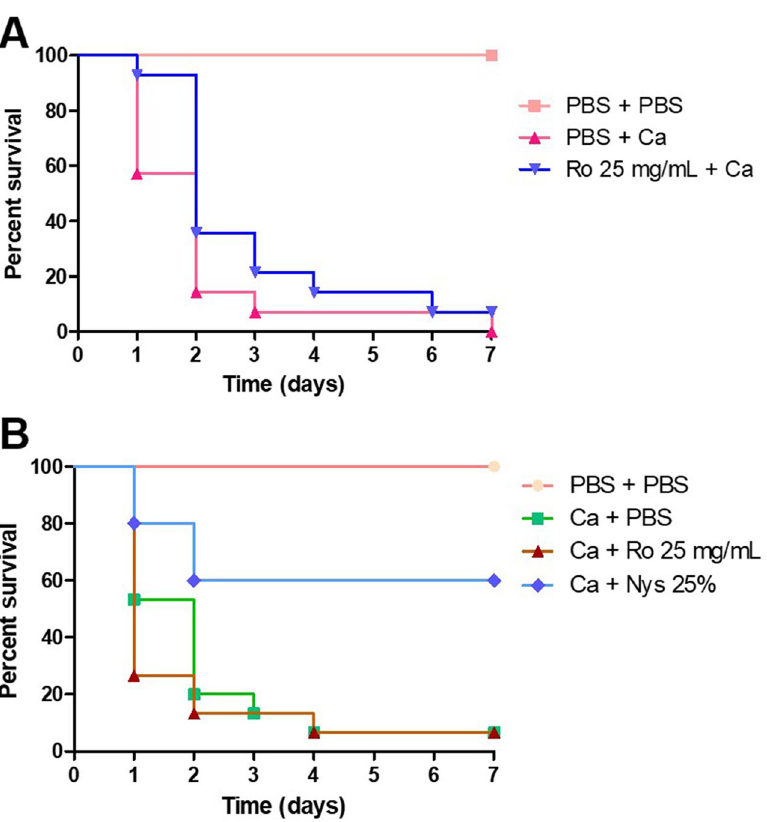
Figure 2. Galleria mellonella survival curve after treatment with different groups. ( A ) To compare the antifungal action of the prophylactic groups with the control group (PBS + PBS). ( B ) To compare the antifungal action of the therapeutic groups with the control group (PBS + PBS). Ca Candida albicans , Ro Rosmarinus officinalis , Nys